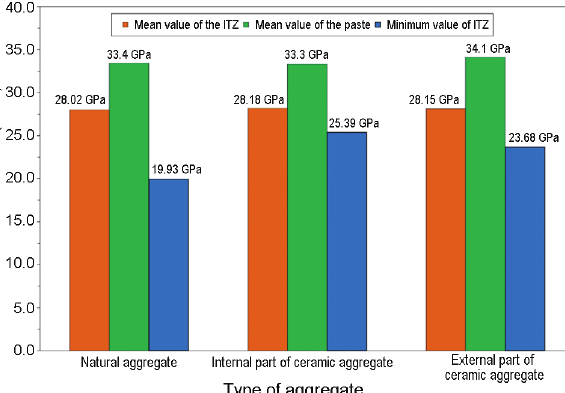
Fig. 8. Mean and minimum values of elastic modulus (GPa) in interfacial transition zone and mean value in